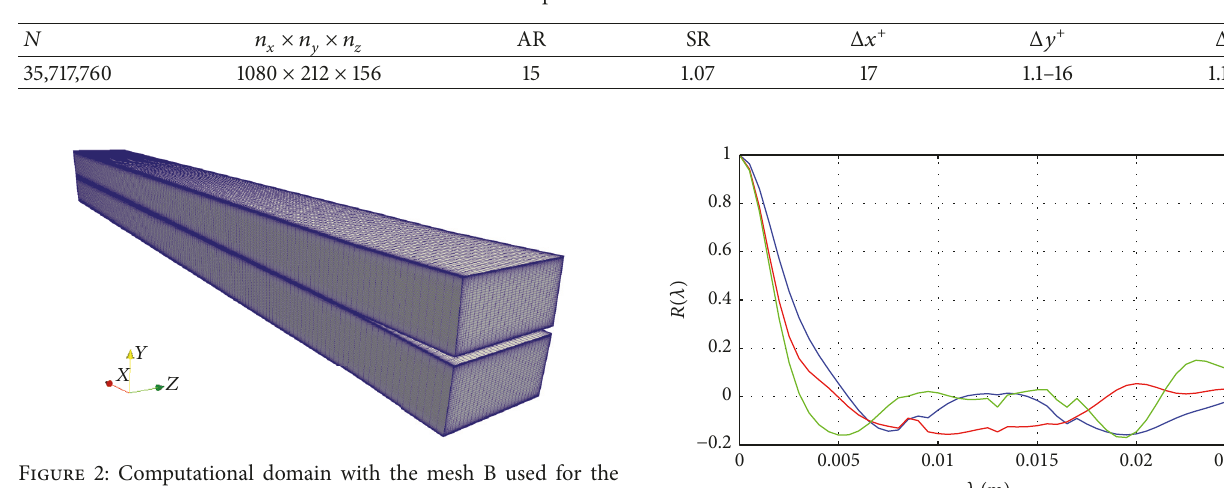
Table 3: Mesh parameters used for LES calculations.